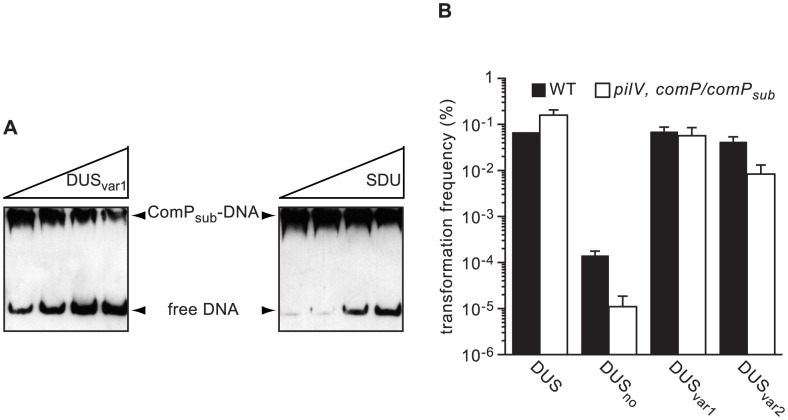
ComP homologs in other human Neisseria species are DNA receptors playing a similar role in transformation to meningococcal ComP.(A) Effect on the ComPsub-DNA complex of the addition of increasing amounts of unlabelled competitor as assessed by acrylamide EMSA. ComPsub and biotin-labelled PCR fragment containing one copy of DUSvar1 were incubated with two-fold increasing concentrations of unlabelled ds DUSvar1 or SDU primers. DNA was then resolved by electrophoresis on an acrylamide native gel, transferred to a positive nylon membrane, UV-crosslinked and detected using a streptavidin-HRP conjugate. (B) Quantification of competence for DNA transformation in the strain 8013 (black bars) and an engineered derivative expressing ComPsub (white bars). Strains were transformed in the presence of 500 µM IPTG using 10 ng of plasmids in which ΔpilN mutant PCR fragments containing DUS, DUSno, DUSvar1 and DUSvar2 have been cloned. Results are expressed as percentages of recipient cells transformed, and are the mean ± standard deviation of five independent experiments.